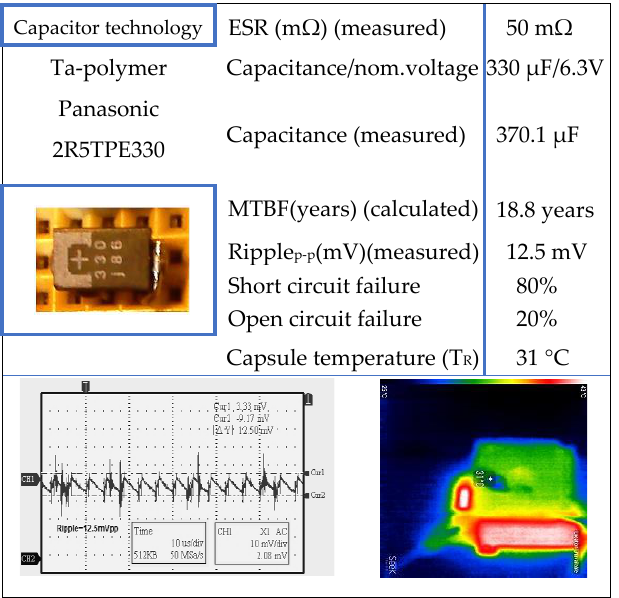
Figure 12. Data taken from measurement, photo of capacitor Ta-polymer 2R5TPE330M7 as DUT (left – center), the actual the ripple’s waveform (left) and surface capacitor’s temperature which is required in reliability calculation (right).